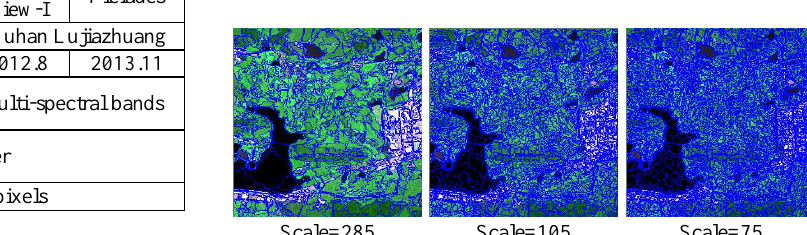
Figure 2 LV and ROC Curves